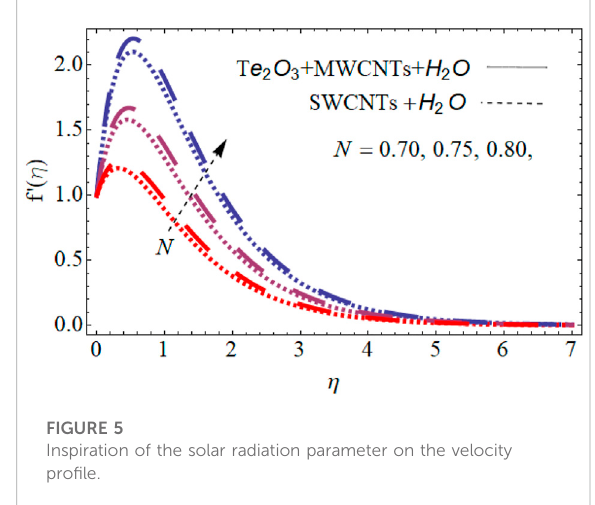
FIGURE 3 Inspiration of the nanoparticle volume fraction on the velocity pro fi le.